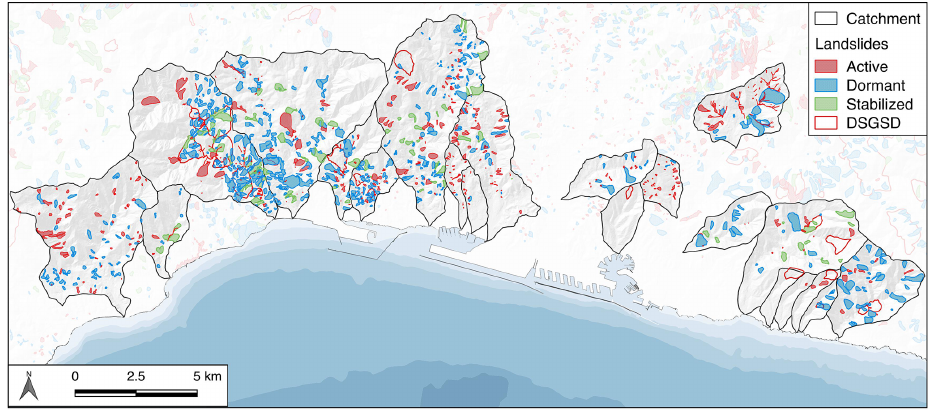
Figure 5. Landslides in the studied catchments discriminated by activity status (IFFI database, 2017 update).